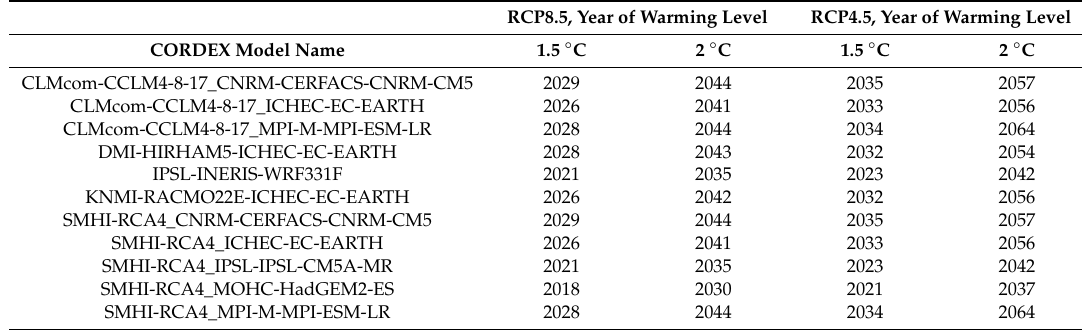
Table 1. Ensemble members and related years when a global warming level (1.5 ◦ C or 2 ◦ C) was surpassed under Representative Concentration Pathways RCP8.5 and